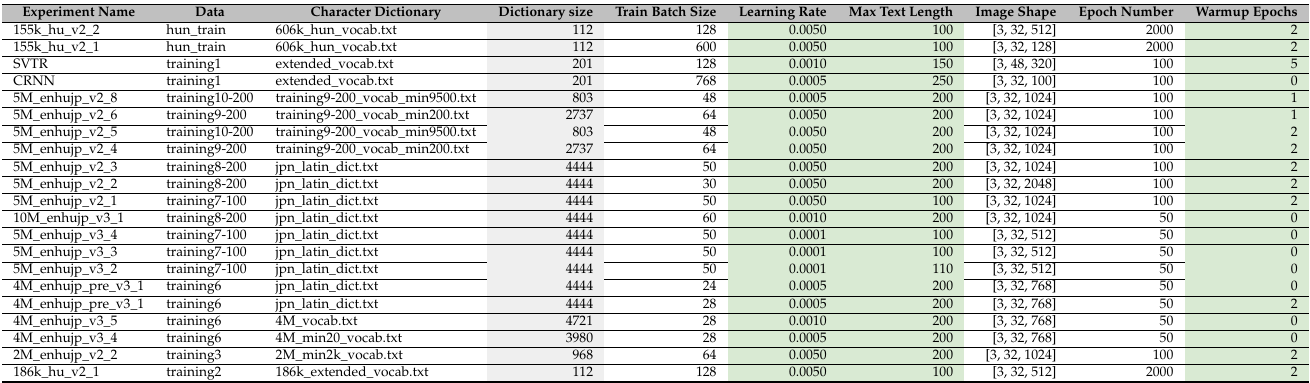
Table 5 highlights the outcome (accuracy) information of the models, using a scaled highlighting table of the most promising results, where green shows the best